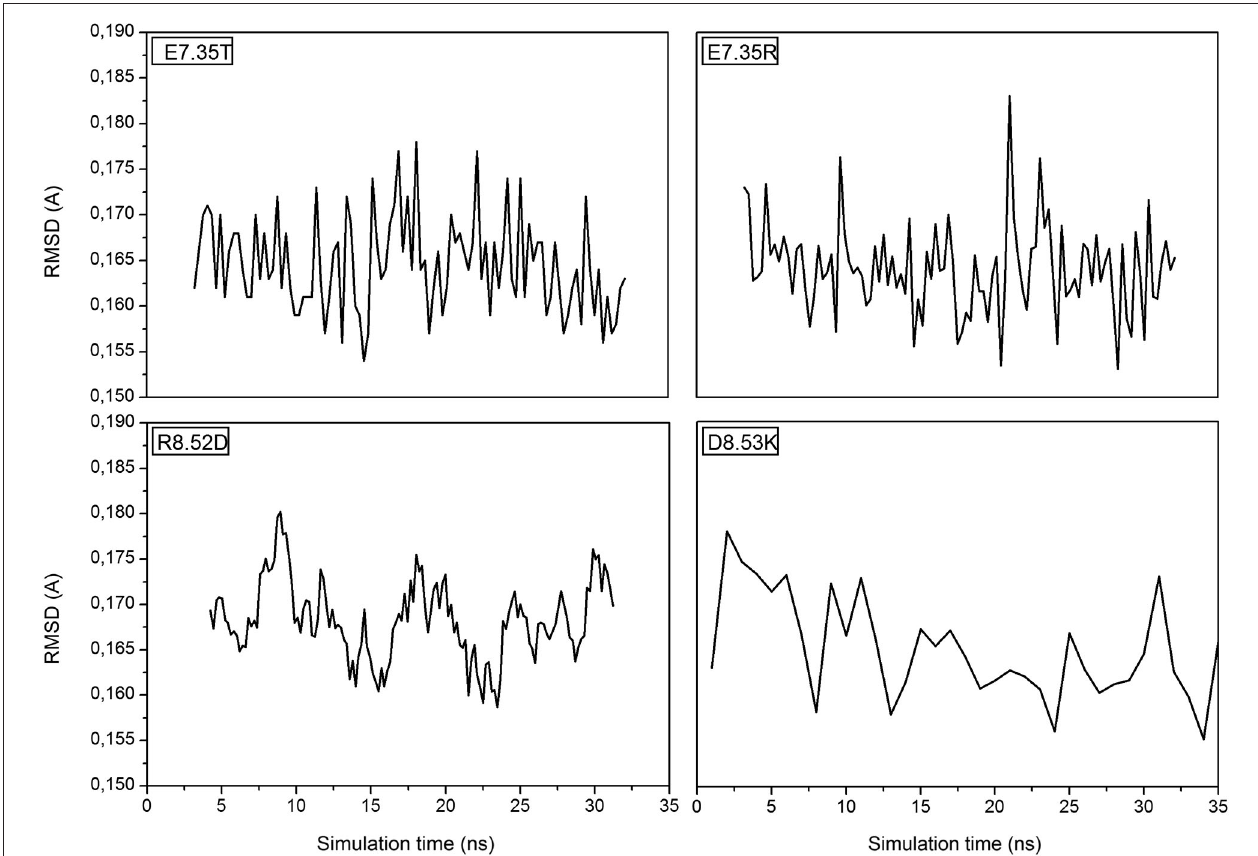
FIGURE 1 | Root Mean Square Deviation (RMSD) is referring to the backbone of the four mutants E7.35T, E7.35R, R8.52D and D8.53K .